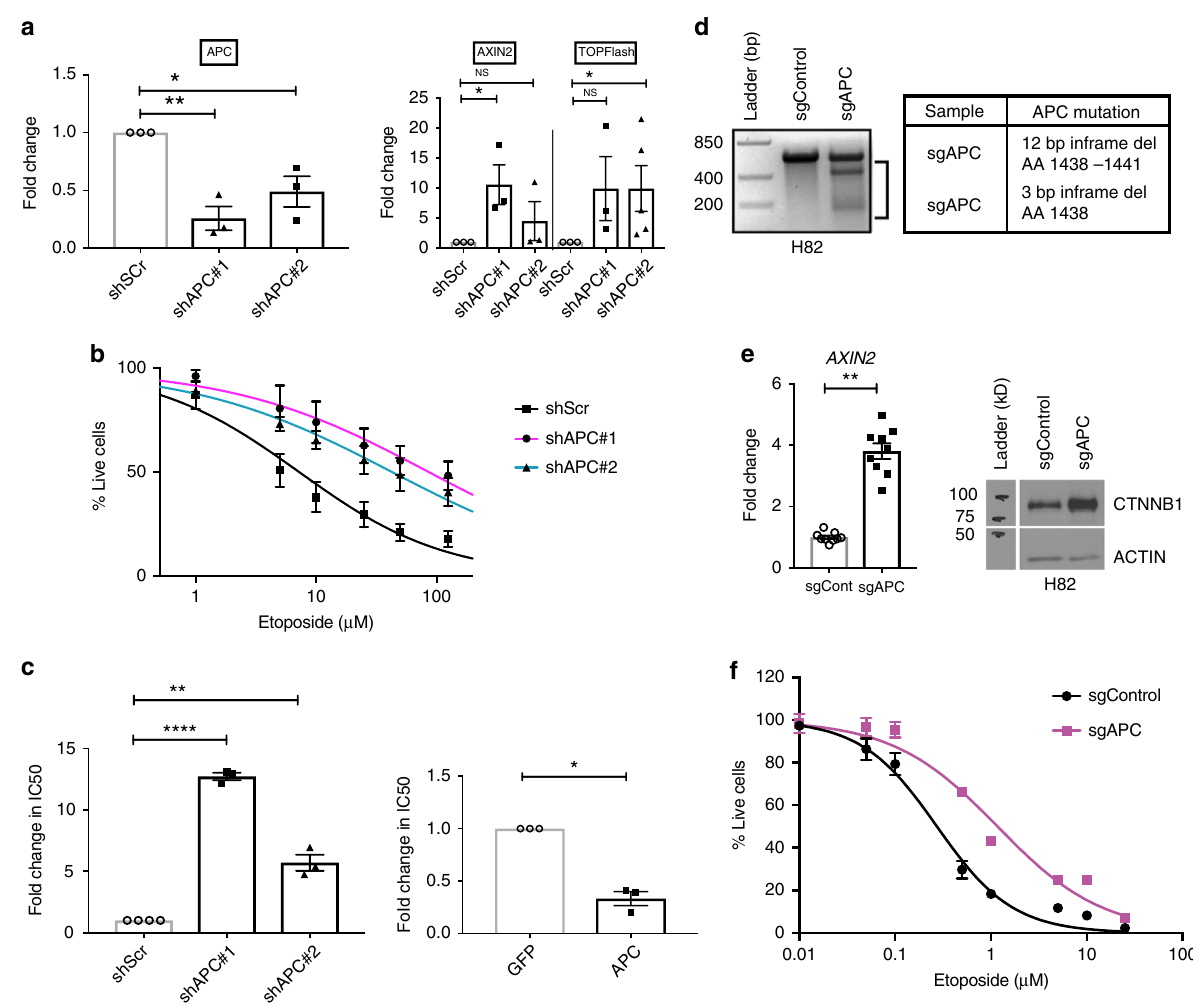
Fig. 4 Loss of APC induces chemotherapy resistance in human SCLC cell lines. a Left: knockdown of APC in H1694 cells with two different shAPC constructs (shAPC#1 and shAPC#2); right: activation of WNT signaling as measured by AXIN2 upregulation and TOPFlash reporter activity (signal fold changes) in these cells. Control cells expressed shRNA with scrambled target sequence (shScr). APC and AXIN2 mRNA levels were measured by quantitative PCR (qPCR). Fold change is reported with respect to control cells, and values were compared using unpaired t tests. Each experiment was performed in biological triplicate (TOPFlash assay results for shAPC#2 are shown from n = 5 experiments). b Percentage of H1694 cells